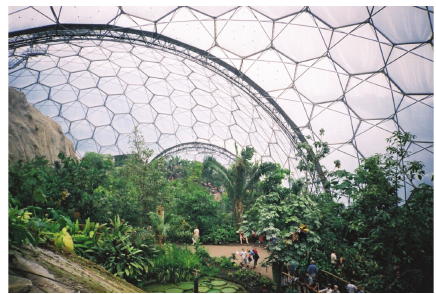
Figure 1: An example of current rigid structures: garden under rig- id dome.